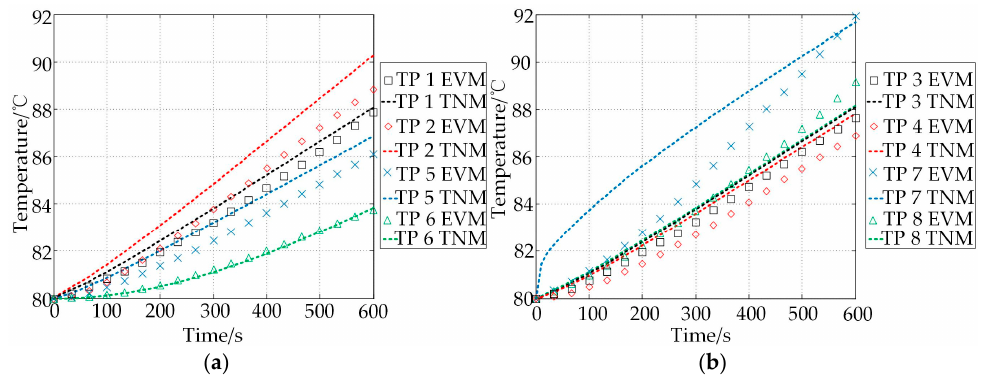
Figure 15. Comparison between the theoretical curves and the experimental curves. ( a ) Comparison curves of point 1, point 2, point 5 and point 6; ( b ) Comparison curves of point 3, point 4, point 7 and point 8.